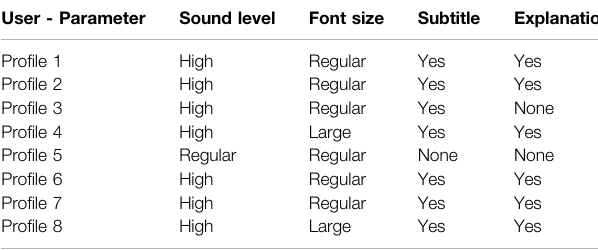
TABLE 2 | Inferred interaction parameters for different pro fi les. User -